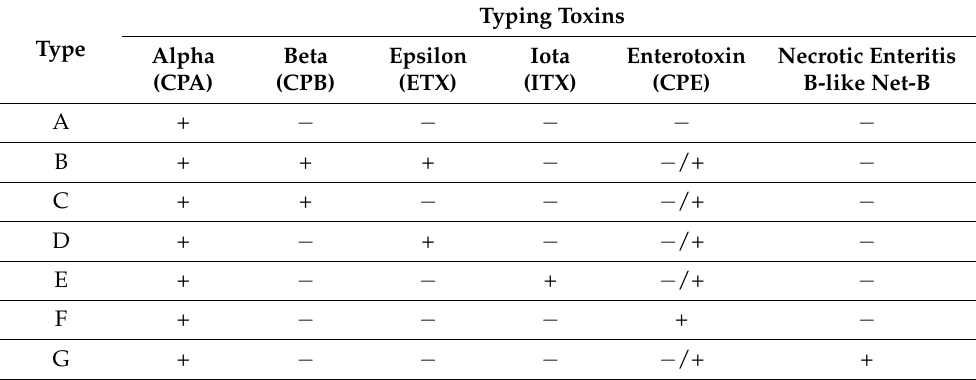
Table 1. Toxinotyping of Clostridium perfringens (modified from Rood et al.,